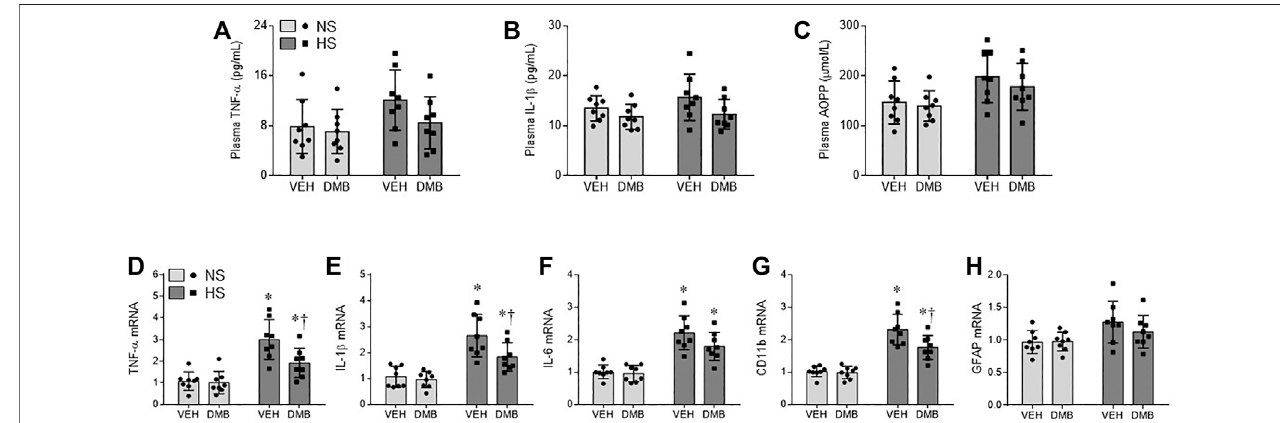
FIGURE 2 | levels of proin fl ammatory cytokines tumor necrosis factor (TNF)- α (A) and interleukin (IL)-1 β (B) , and levels of systemic oxidative stress marker advancedoxidationproteinproducts(AOPP, C )inplasma,andmRNAexpressionofTNF- α (D) ,IL-1 β (E) andIL-6 (F) ,microgliamarkerCD11b (G) andastrocytemarker GFAP (H) in the PVN, in rats fed a normal salt (NS) diet or a high salt (HS) diet and simultaneously treated with vehicle (VEH) or 1.0% 3,3-Dimethyl-1-butanol (DMB, an inhibitor of trimethylamine formation). All data are expressed as mean ± SEM ( n = 8 rats/per group). p p < 0.05 vs . NS + VEH; † p < 0.05, HS + DMB vs . HS +